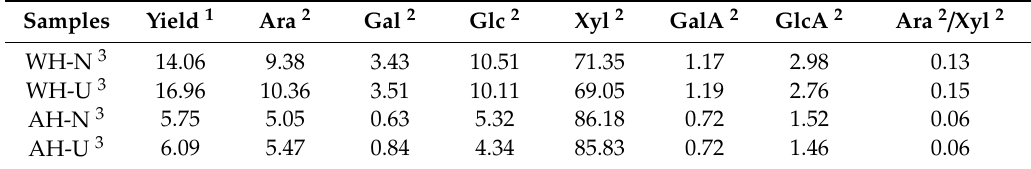
Table 3. Yield (% hemicelluloses) and sugar composition of hemicellulose fractions.